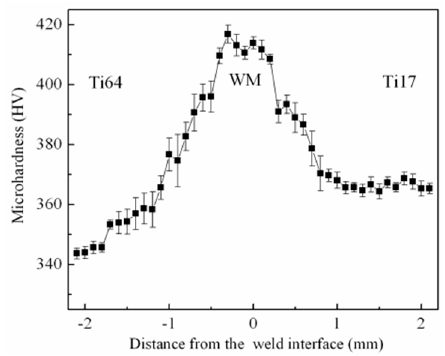
Figure 6. Transverse hardness of LFW joints with Ti64 and Ti17 alloys.